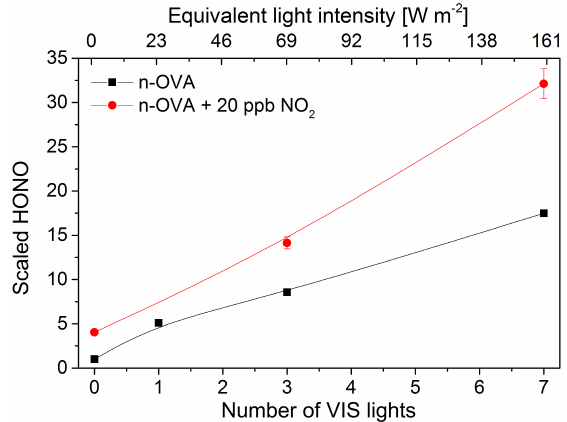
Figure 3. Light-enhanced HONO formation from TNM-nitrated proteins (n-OVA: ND 12.5%, coating 21.5µgcm − 2 ). Black squares indicate HONO formation via decomposition from nitrated proteins (without NO 2 ) while red squares indicate additional HONO for- mation via heterogeneous NO 2 conversion (20ppb NO 2 ) at 50% RH (HONO is scaled to the HONO concentration measured with- / [ HONO ] dark; NO out NO 2 and no light ( [ HONO ] lights; NO 2 2 = 0